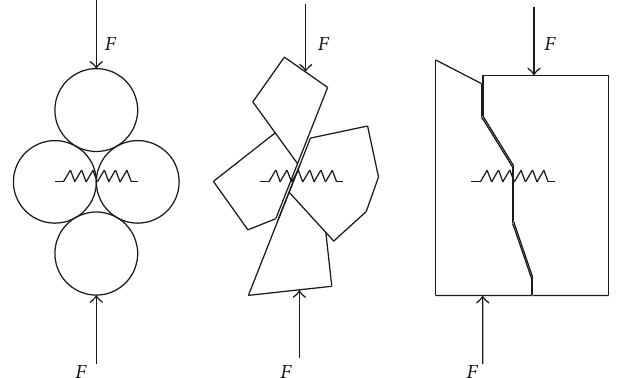
Figure 16: Illustration of the compression-induced tension crack mechanism.